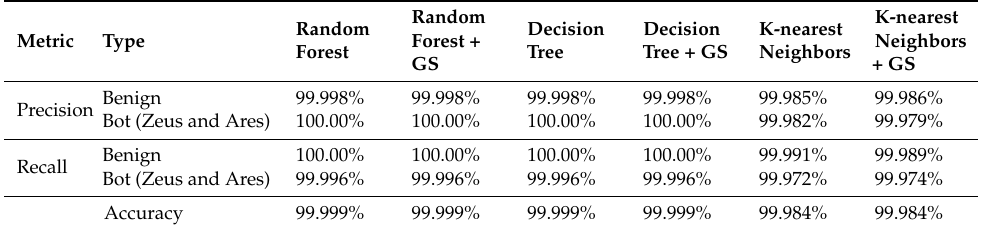
Table 3. Comparative analysis of ML models on the CIC-AWS-2018 dataset filtered by Transmission Control Protocol (TCP) (A).